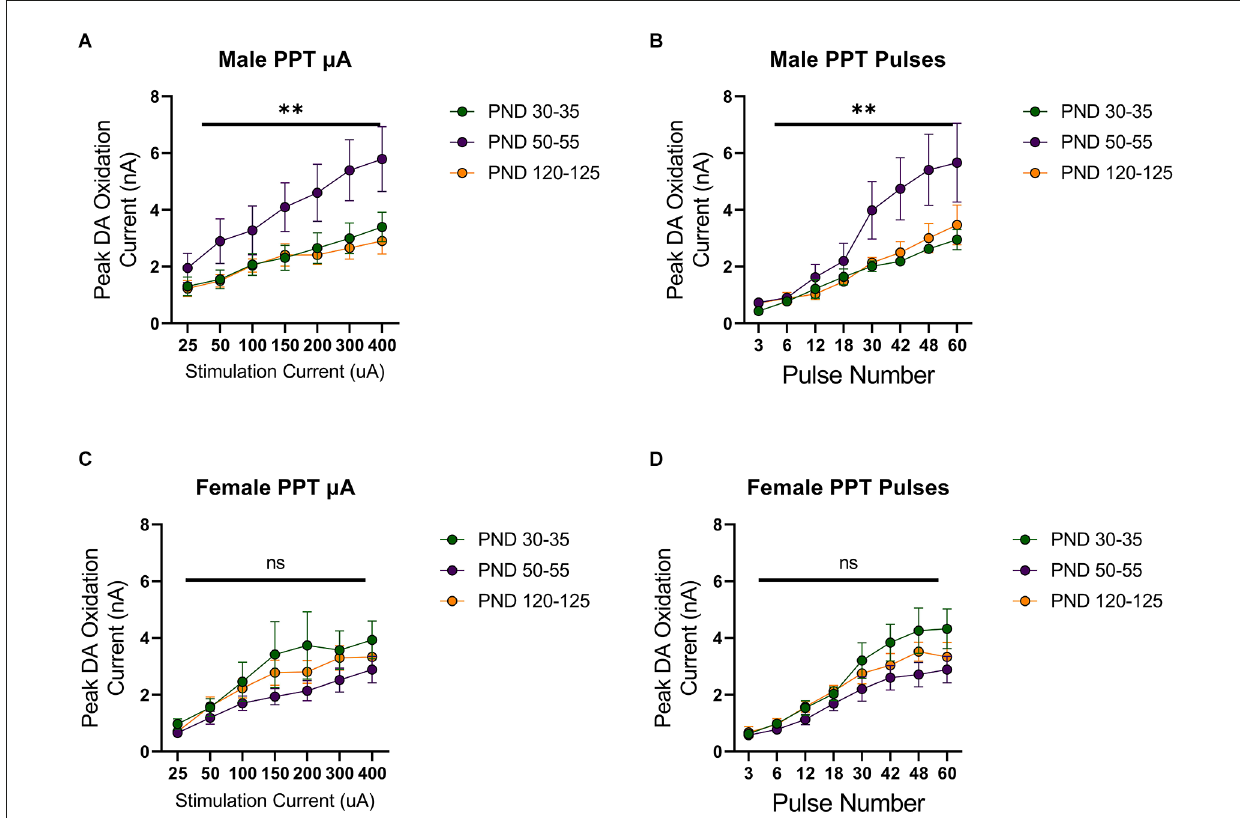
FIGURE2 Peak DA oxidation current (nA) recordings in the NAcc over time after a single electrical stimulation of the pedunculopontine tegmental nucleus (PPT) in Males (A,B) and Females (C,D) averaged over varying stimulation current (A,C) and pulses (B,D) at various ages. (A) Males’ PND 50–55 ( n = 6) significantly differed from PND 30–35 ( n = 7) and PND 120–125 ( n = 4) in phasic DA release in the NAcc after stimulation of the PPT with increasing stimulation current. (B) Males’ PND 50–55 ( n = 5) significantly differed from PND 30–35 ( n = 4) and PND 120–125 ( n = 4) in phasic DA release in the NAcc after stimulation of the PPT with increasing pulse number. (C) Females’ PND 50–55 ( n = 6) significantly differed from PND 30–35 ( n = 4) and P120–125 ( n = 4) in phasic DA release in the NAcc after stimulation of the PPT with increasing stimulation current. (D) Females’ PND 50–55 ( n = 5) significantly differed from PND 30–35 ( n = 4) and PND 120–125 ( n = 4) in phasic DA release in the NAcc after stimulation of the PPT with increasing pulse number. All data are presented as mean ± SEM for the peak DA oxidation current according to stimulation current (25, 50, 100, 150, 200, 300, and 400 nA) and pulse number (3, 6, 12, 18, 30, 42, 48, and 60). ∗∗ p < 0.01 and ns p > 0.05.